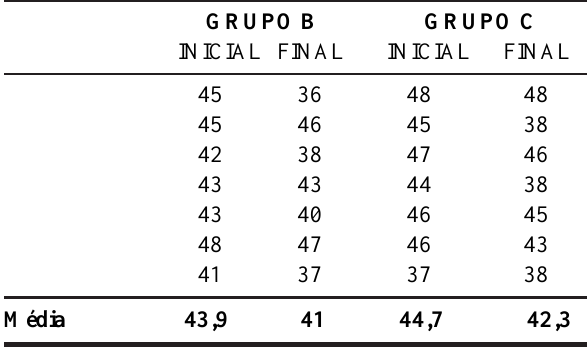
TABELA 2 - Diâmetro abdominal (cm) dos cães dos Grupos